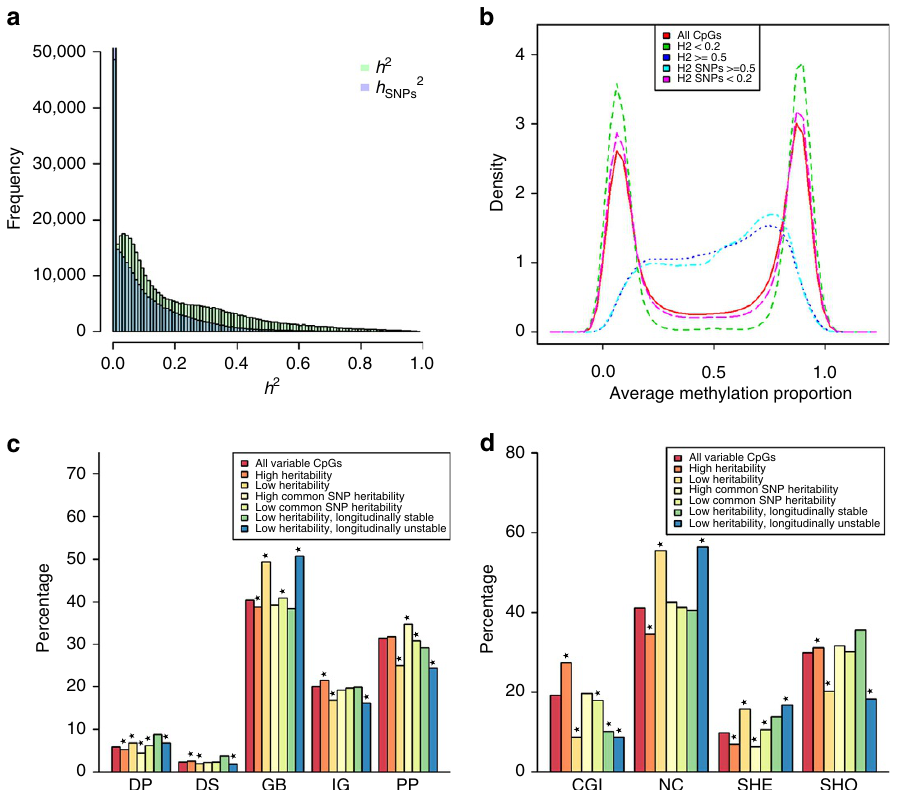
Figure 3 | Variance explained by SNPs and longitudinal stability. ( a ) Histogram of total additive heritability ( h 2 total) of DNA methylation (green) and variance explained by genome-wide SNPs ( h 2 SNPs, purple) for genome-wide CpGs. The y axis is truncated. ( b ) Density plot of methylation sites with a high versus low heritability. ( c ) Distribution of methylation sites grouped based on heritability and longitudinal stability relative to genes: DP, distal promoter; DS, downstream region; GB, gene body; IG, intergenic; PP, proximal promoter. ( d ) Distribution of methylation sites grouped based on heritability and longitudinal stability in relation to CpG density: CGI, CpG island; NC, non-CGI; SHE, CpG island shelf; SHO, CpG island shore. Asterisks denote significant enrichment or depletion ( a ¼ 4.27 (cid:2) 10 (cid:3) 4 , w 2 -test). Results of DNA methylation heritability are from the GRM-based approach in 2,603 individuals. Longitudinal stability was assessed in 31 subjects with data from two longitudinally collected blood